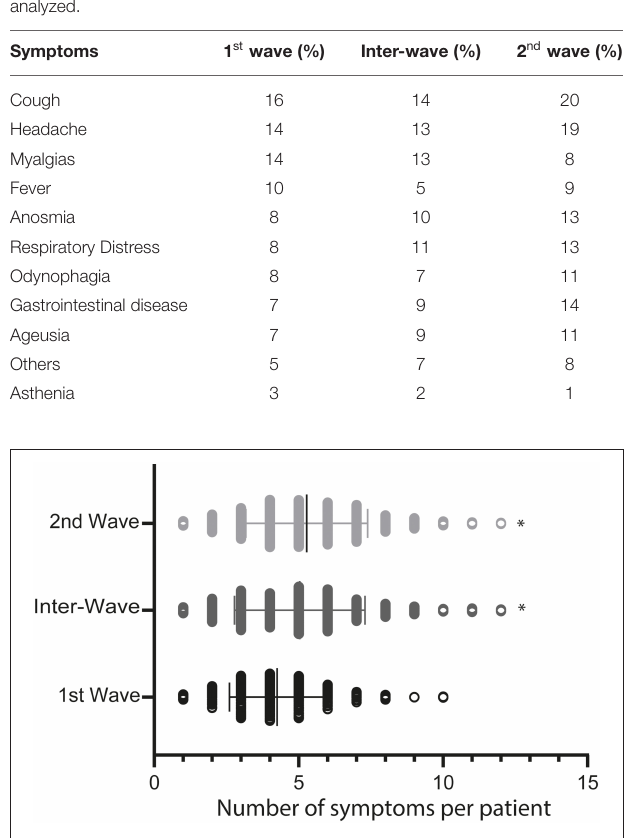
FIGURE 2 | The number of symptoms per patient in the first, inter, and second waves. The graph corresponds to the number of symptoms per patient from the 1,694 positive tests per analyzed period. * p < 0.05. Each period is shown with the mean value.